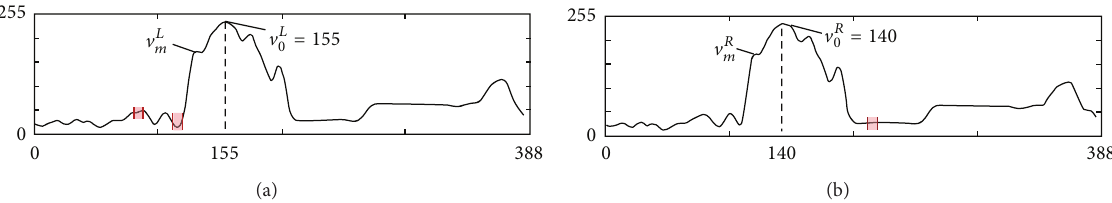
Figure 1: Gaussian filtered intensity profiles of corresponding rows from the left (a) and right (b) Tsukuba images, with two labeled shape vertices, and highlighted regions that represent discontinuities.